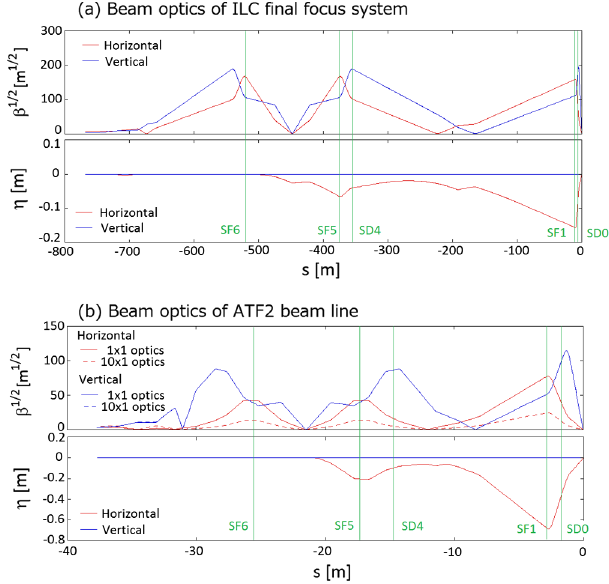
FIG. 2. Beam optics of the ILC final focus beam line (a) and the ATF2 beam line (b). Both the 1 × 1 optics and the 10 × 1 optics are shown. FIG. 3. Tolerances of multipole field errors for the final doublet